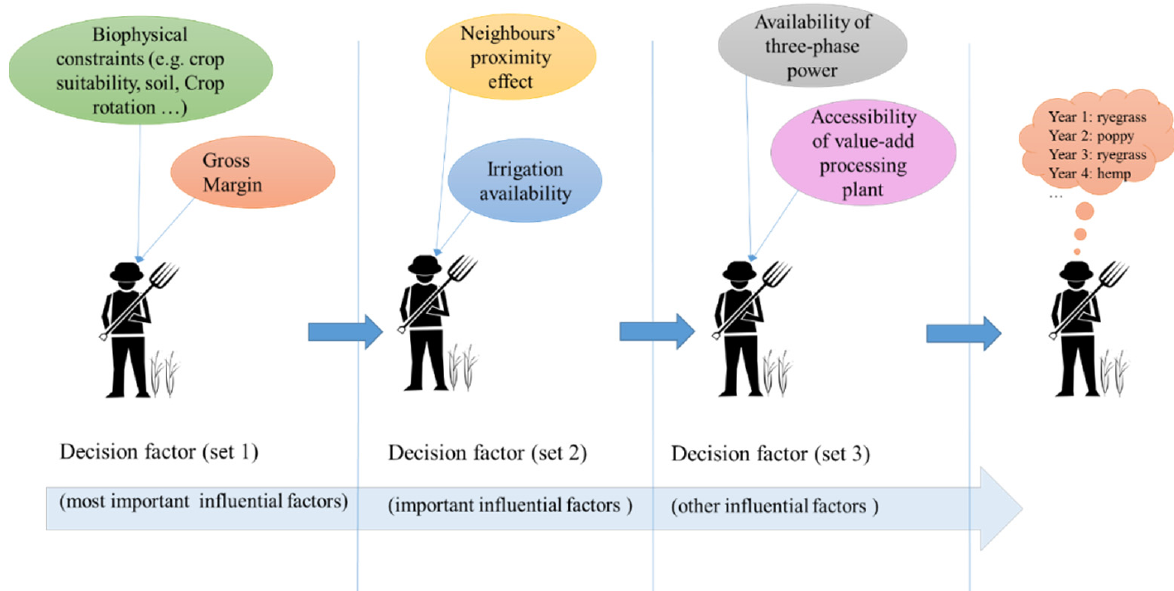
Figure 2. Illustration of social, economic and biophysical factors in the conceptualisation of a sequence of decision steps.